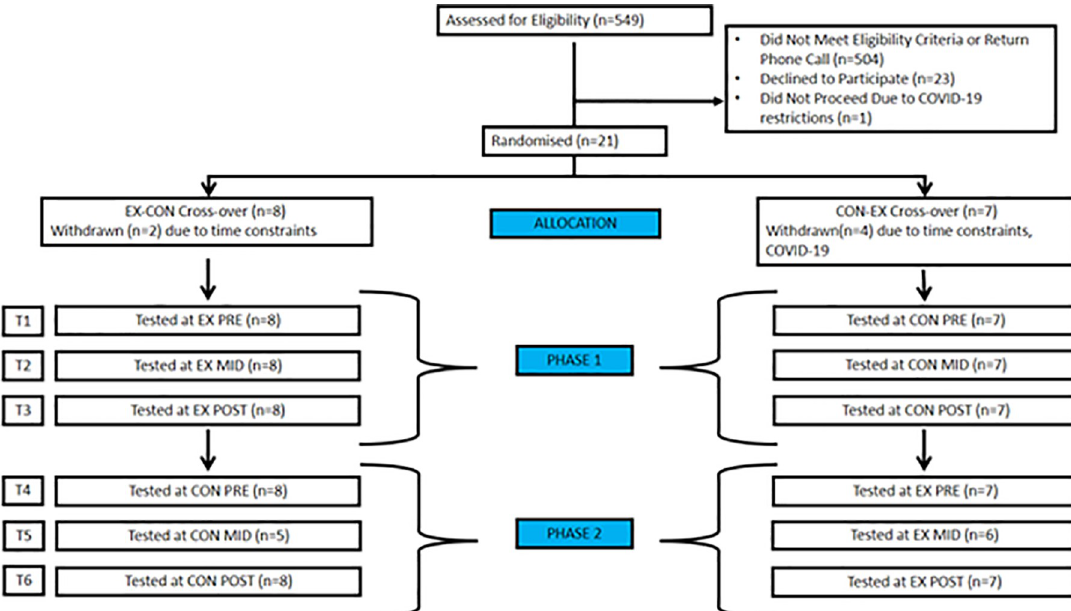
Fig 1. Flow of participants through study. T1: time point 1 (initial of phase 1); T2: time point 2 (mid way of phase 1); T3: time point 3 (final of phase 1); T4: time point 4 (initial of phase 2); T5: time point 5 (mid way of phase 2); T3: time point 3 (final of phase 1); T6: